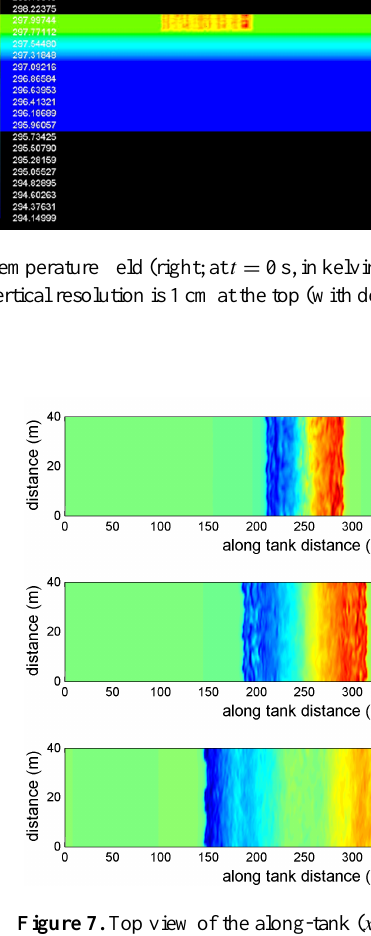
Figure 6. Close-up of a side view of temperature (in kelvin) illus- trates the propagation of the low-density buoyancy-driven current in the near-surface layer. The propagating flow has the form of a classical gravity current with a leading head and trailing tail region. Internal waves can be seen in the thermocline. Time evolution is from top to bottom. Top: after time 300s, middle: after 1500s, bot- tom: after 2000s.